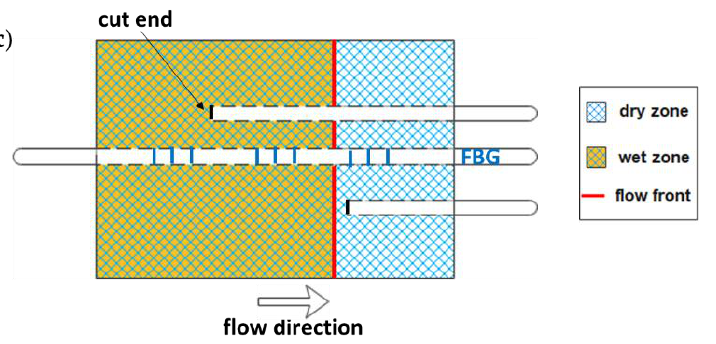
Figure 10. ( a ) Sensing principle of fiber optics based on Fresnel law (adapted from Chehura et al. [96]), ( b ) a sketch of the Fiber Bragg Grating structure, and ( c ) an example of embedded fiber optics application for flow front monitoring.